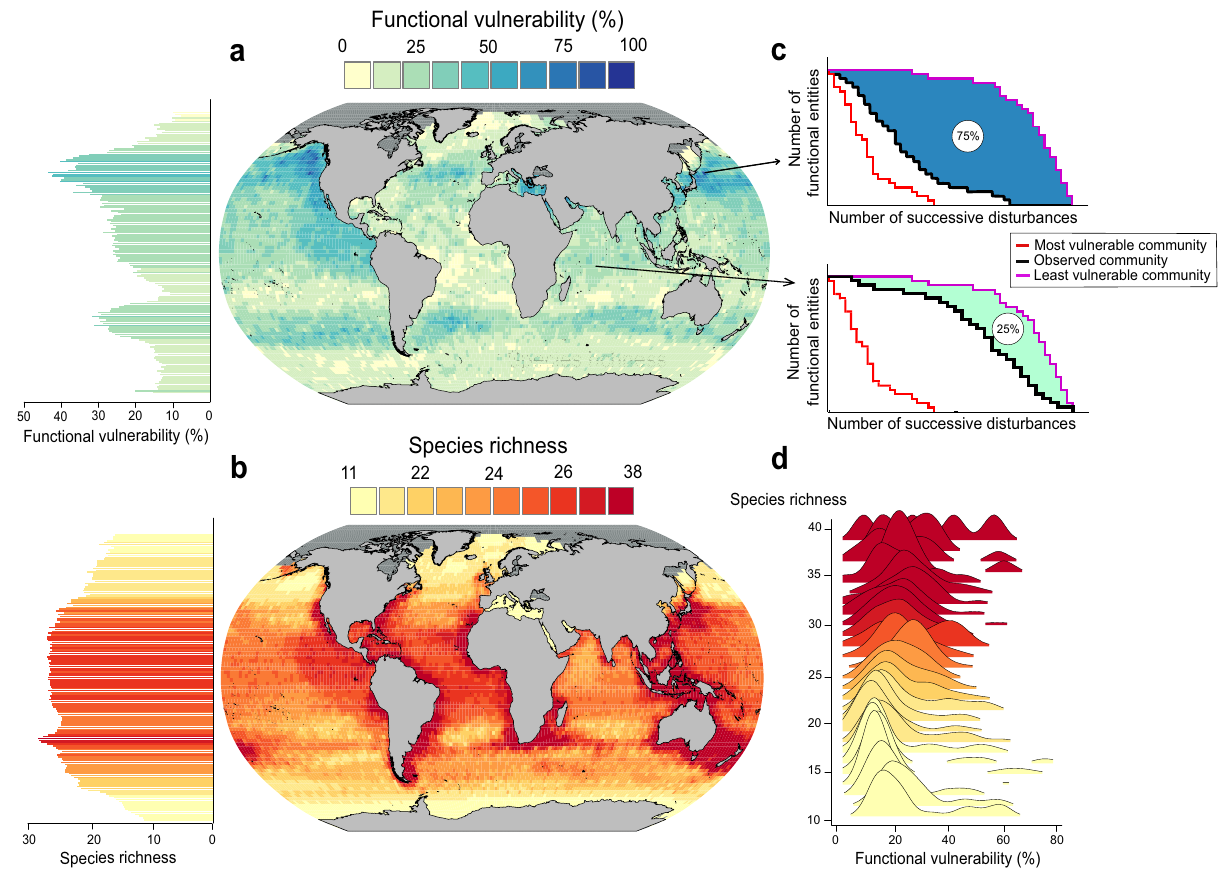
Fig. 3 | Functional vulnerability and species richness in marine mammal com- munities. a Functional vulnerability of marine mammal communities at global scale. b Species richness of marine mammal communities. c Rarefaction curves of two contrasting communities according to their functional vulnerability (25 and 75%).Theredandvioletcurvescorrespondtotherarefactioncurveofthemostand least vulnerable communities, respectively. The black curve corresponds to the